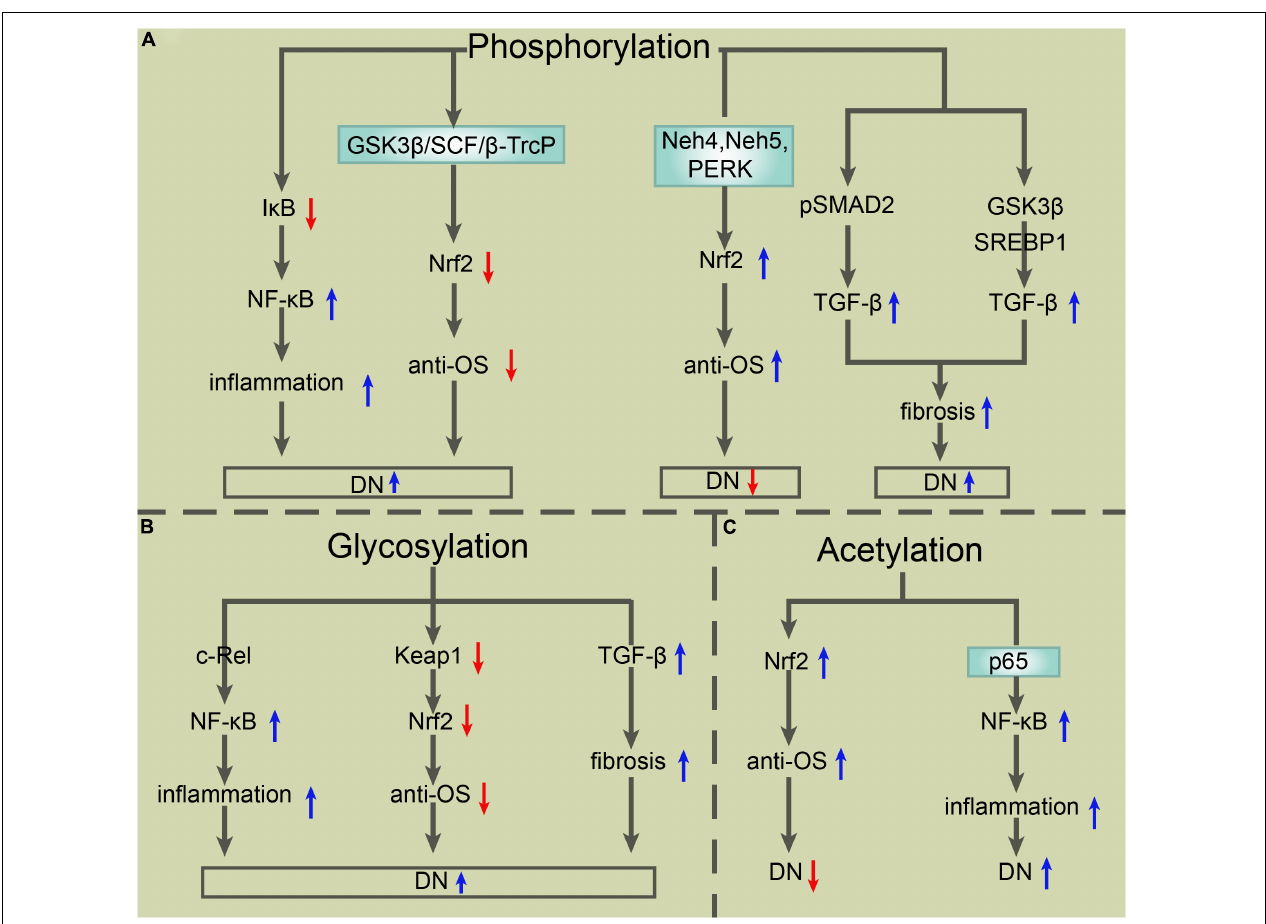
FIGURE 3 | The roles of other PTMs in the modulation of TGF- β , NF- κ B, and Nrf2 in DN. (A) Phosphorylation of I κ B triggers its degradation, which results in the activation of NF- κ B and consequent exacerbation of inflammation and DN. Phosphorylation-mediated Nrf2 degradation via GSK-3 β in an E3 ligase SCF/ β -TrCP-dependent manner exacerbates DN as well, while phosphorylation of Nrf2 via Neh4, Neh5, or PERK induces Nrf2 activation and consequent improvement of DN. Phosphorylated pSMAD2 or phosphorylation-mediated GSK3 β /SREBP1 activation upregulates TGF- β expression, which enhances fibrosis and then exacerbates DN. (B) O -GlcNAcylation of the subunit c-Rel results in NF- κ B activation, which exacerbates inflammation and DN. O -GlcNAcylation of Keap1 at serine 104 induces the degradation of Nrf2 and consequent exacerbation of DN. Core fucosylation-mediated upregulation of TGF- β /SMAD promotes fibrosis and the progress of DN. (C) Acetylation of Nrf2 enhances its antioxidative stress capacity, which exerts protection for DN. Acetylation of p65 at lysine 221 is closely related to NF- κ B activation, which aggravates the inflammatory response and DN. PTMs, posttranslational modifications; TGF- β , transforming growth factor β ; NF- κ B, nuclear factor-kappa B; Nrf2, NF-E2-related factor 2; DN, diabetic nephropathy; Neh4, Nrf2 ECH homology 4; PERK, protein kinase RNA-like endoplasmic reticulum kinase; GSK-3 β , glycogen synthase kinase-3 β ; SREBP, sterol regulatory element-binding proteins; O -GlcNAc, O -linked β - N